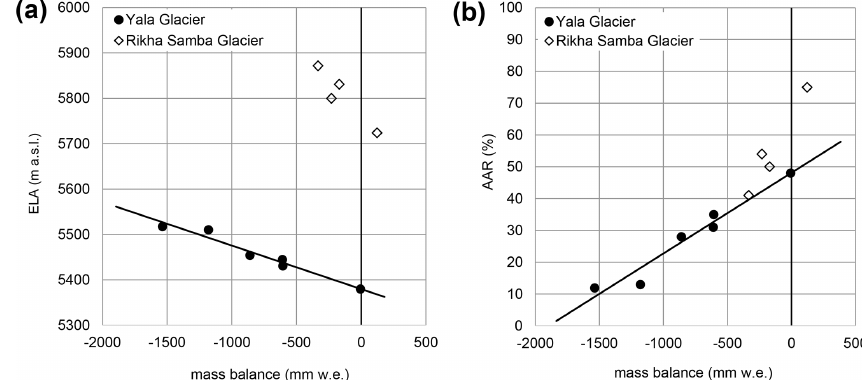
Figure 5. The ELA (a) and AAR (b) of Yala and Rikha Samba glaciers against the mass balance. The ELA 0 and AAR 0 for the glaciers are 5377ma.s.l. and 5760ma.s.l. and 0.49 and 0.66 for Yala and Rikha Samba glaciers, respectively.